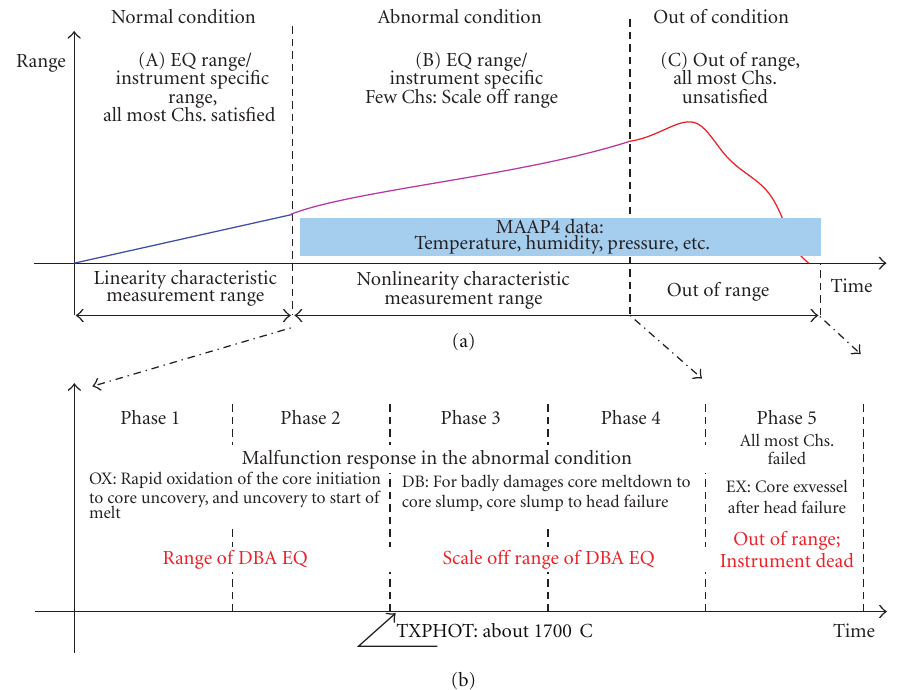
Figure 4: Three EQ conditions and five phases of a scenario taken by MAAP4 code.